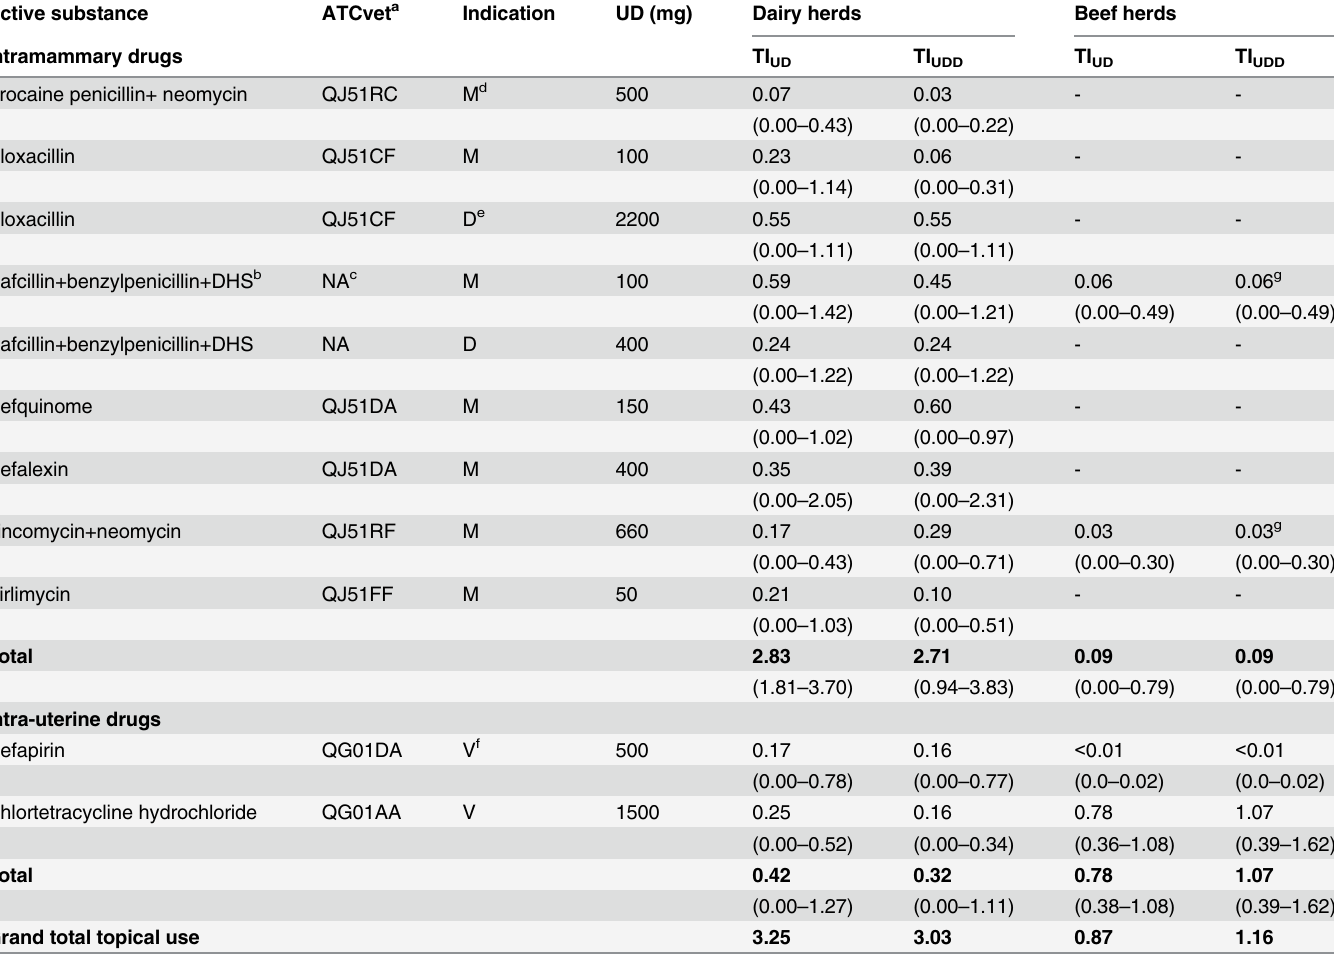
Table 2. Treatment incidences (min-max) based on the animal unit dose (UD; TI UD ) and prescribed daily dose (UDD; TI UDD ) of the topical antimicro- bial drugs in the different herd